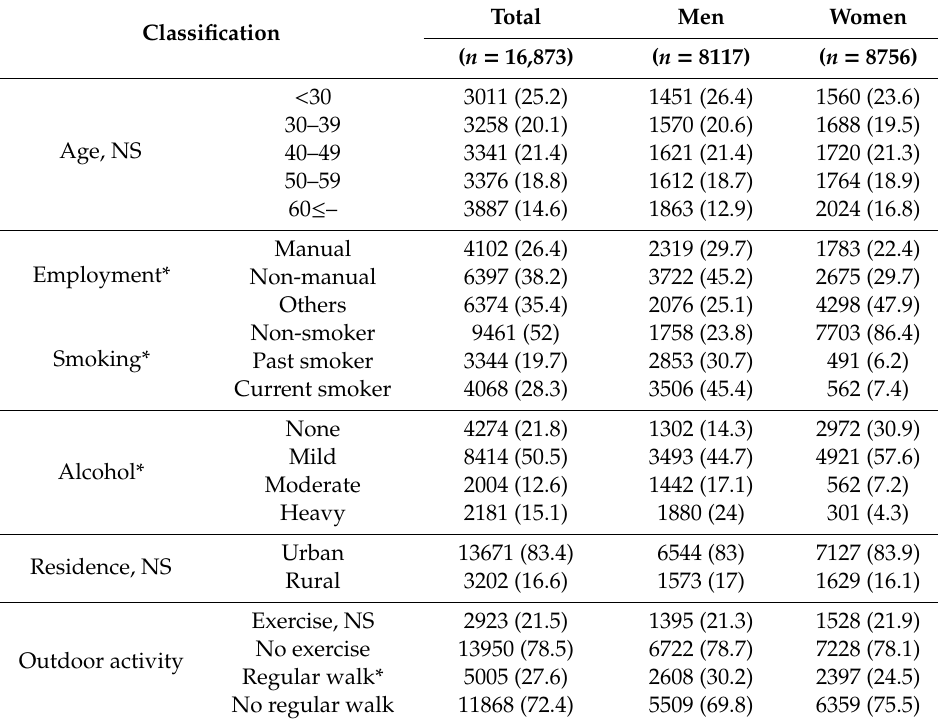
Table 1. General demographic characteristics of study